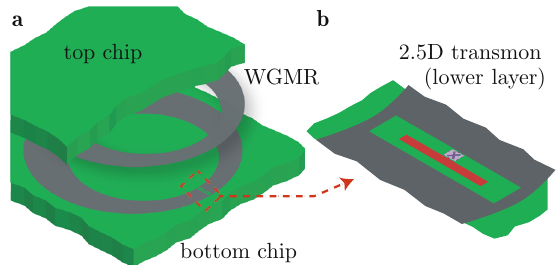
Fig. 7 Illustration of fl ip-chip (2.5D) device WG1. a Depiction (not to scale) of chip stack consisting of two chips separated by a 100 μ m vacuum gap. The inner face of each chip supports part of the pattern of a multi-layer whispering gallery-mode resonator (WGMR) resona- tor 53 . The lower layer contains a 2.5D, aperture transmon qubit 28 embedded in the WGMR. b Zoomed-in view of the lower layer of the aperture transmon. The cross marks the location of the Josephson tunnel junction device, which connects the lower center trace to an island embedded in the lower aperture. The capacitance to the top layer signi fi cantly participates in determining qubit parameters.